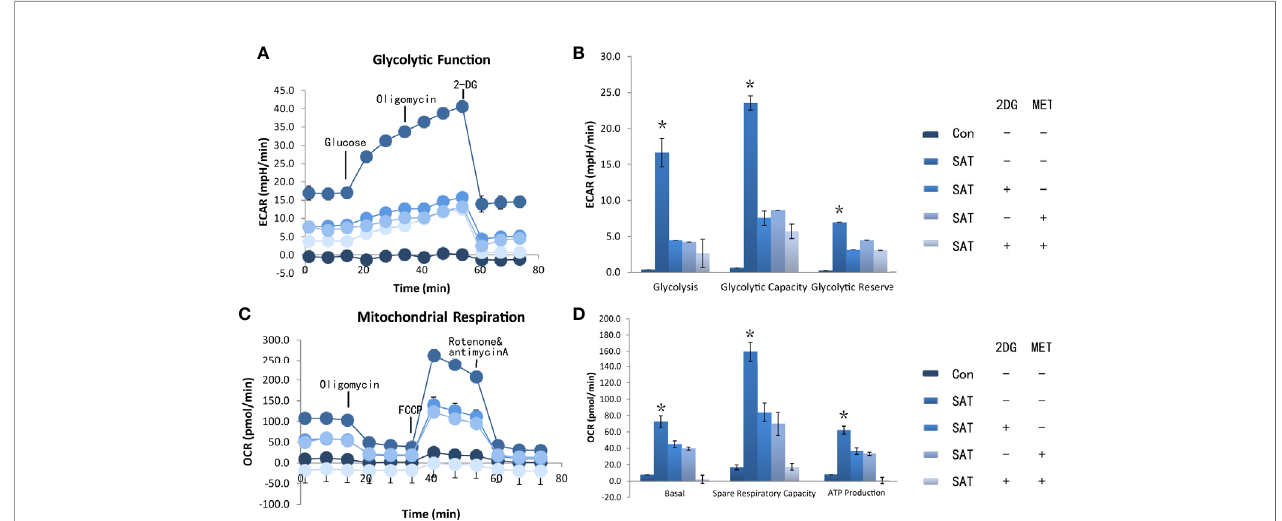
FIGURE 3 | 2DG and metformin reverted CD4+ T cell metabolic dysfunction in vivo . The NOD-2h4 mice were raised and given excess iodine to form a murine model of SAT. After 8 weeks three groups of mice for treatment with 2DG, metformin, or a combination of 2DG and metformin (n = 7 per group). CD4+ T cells was extracted from these mice and the basal ECAR (A) , glycolysis capacity and glycolysis reserve of CD4+ T cells of ever group (B) . The basal OCR, spare respiration capacity and ATP production of CD4+ T cells of every group were measured by seahorse (C, D) . ECAR, extracellular acidi fi cation rate; OCR, oxygen consumption rate. *P <